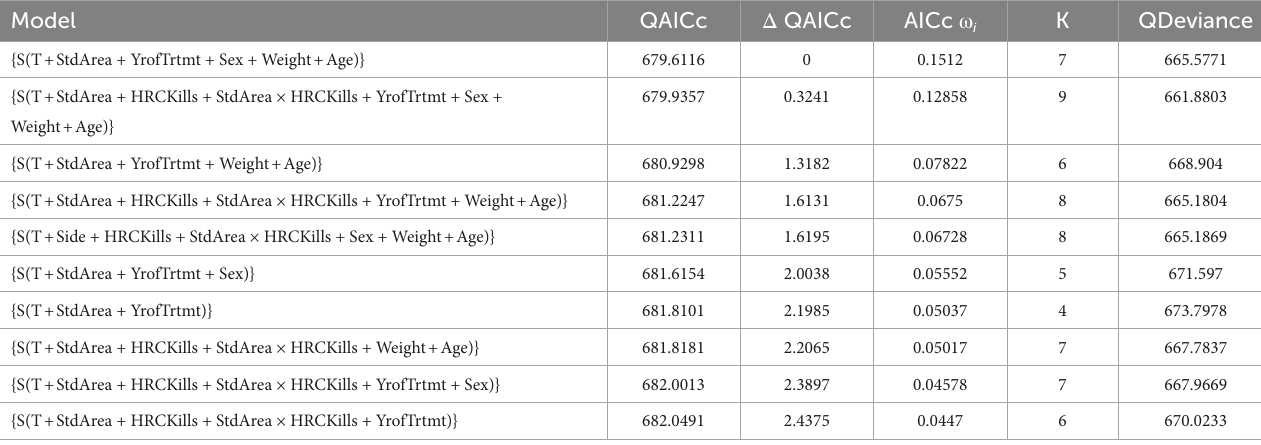
TABLE 3 Model selections results for survival of neonate mule deer through 16 weeks of age on Monroe Mountain, Utah during 2012–2015. Model